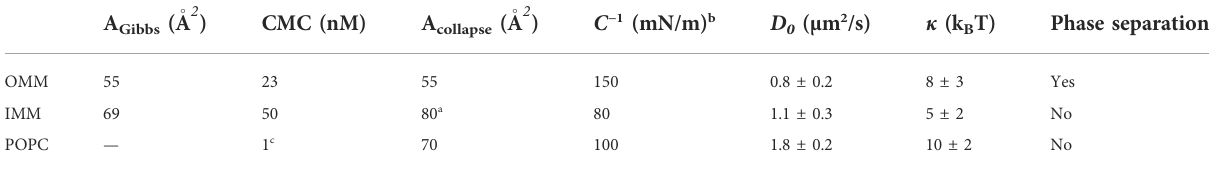
TABLE 2 Physicochemical parameters of OMM and IMM lipid extracts. (cid:1) A Gibbs ( A 2